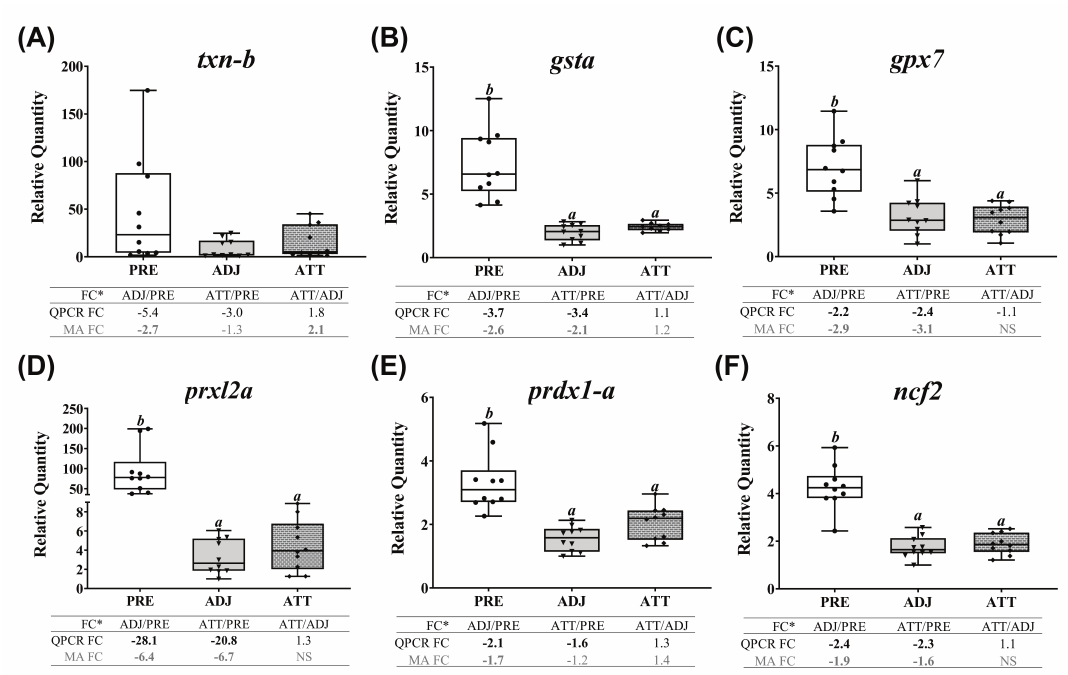
Figure 10. QPCR confirmation of selected microarray-identified transcripts in theme 5 (Tables 1 and 3) that are associated with antioxidant activity and redox homeostasis. For details of the captions, refer to Figure